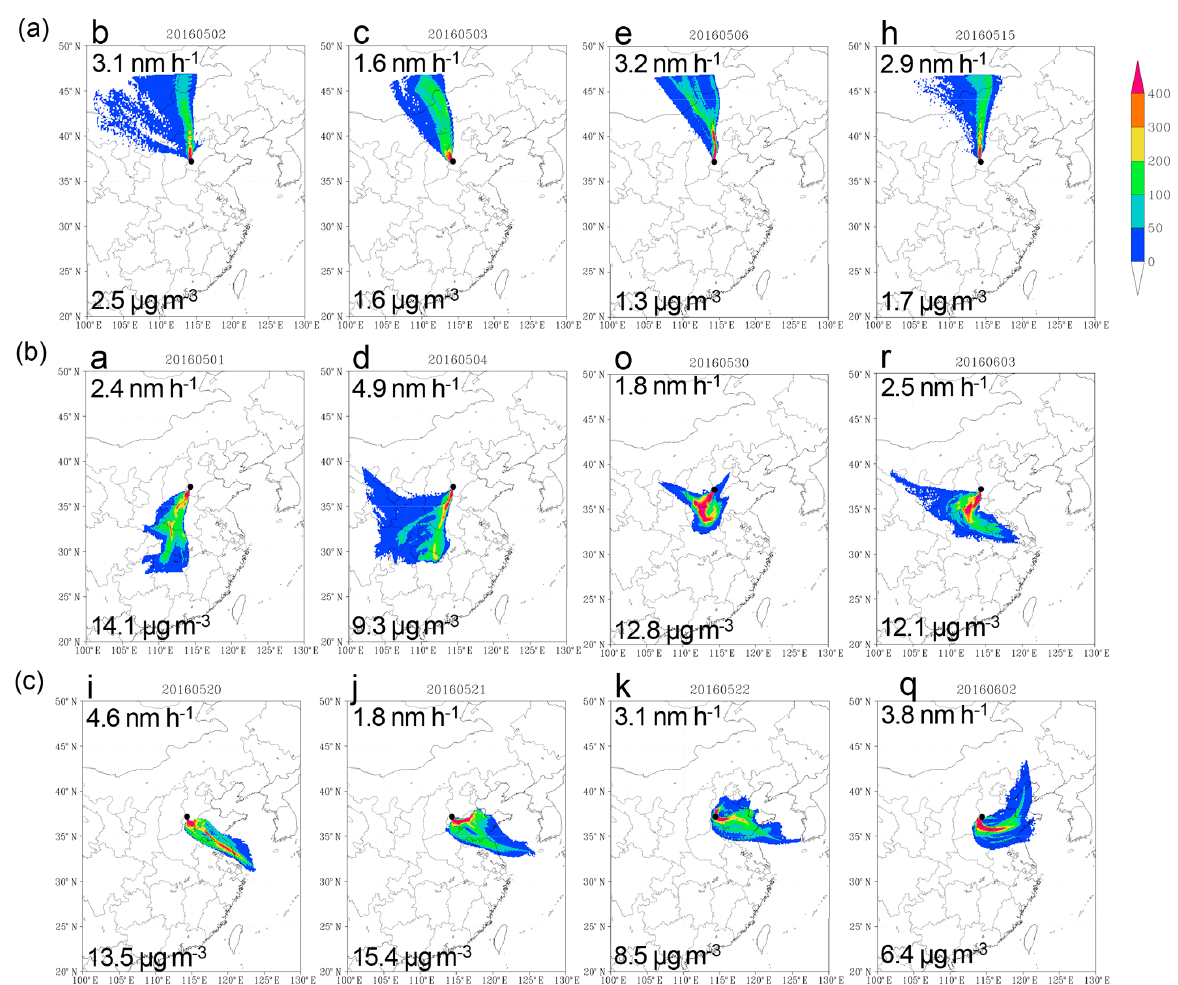
Figure 11. Particle GR and sulfate concentrations during the days shown in Fig. 10a with different footprints: (a) north, (b) southwest, and (c)